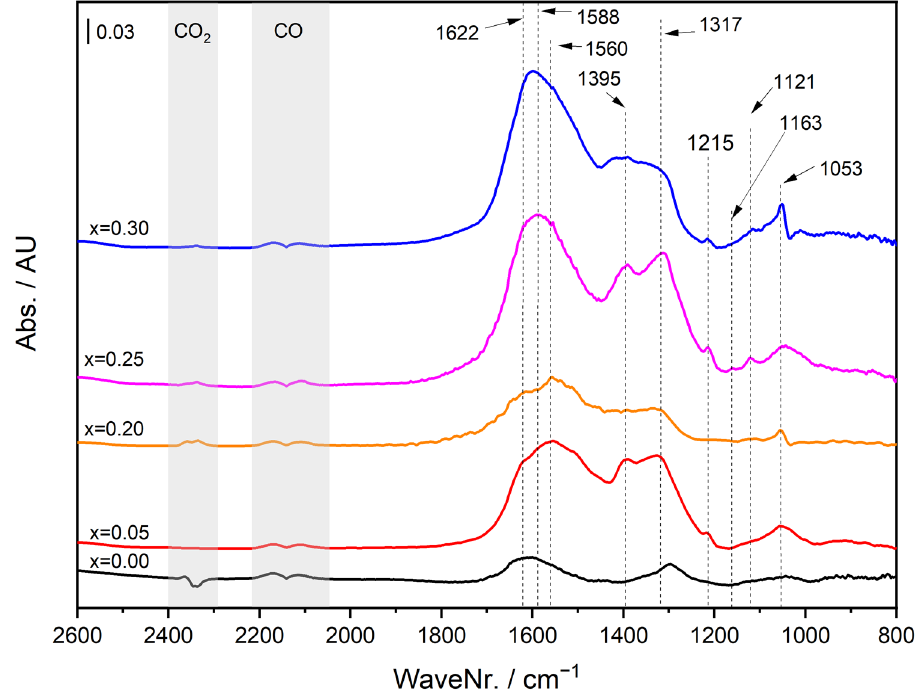
Figure 8. DRIFTS spectra of the selected 20% O 2 -treated catalysts after 40 min of exposure to the probe gas of 0.2% CO in He at 10 °C. The labels represent the Co content in the catalysts.